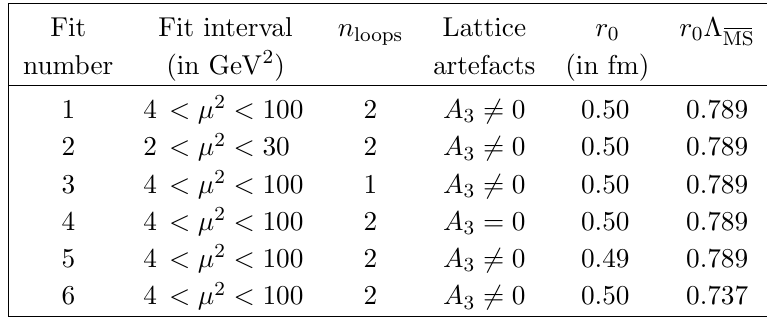
Table 3 . Choices for the (cid:12)ts of the renormalization and mixing coe(cid:14)cients. renormalization factors Z V and Z T needed for the evaluation of f are calculated in the same